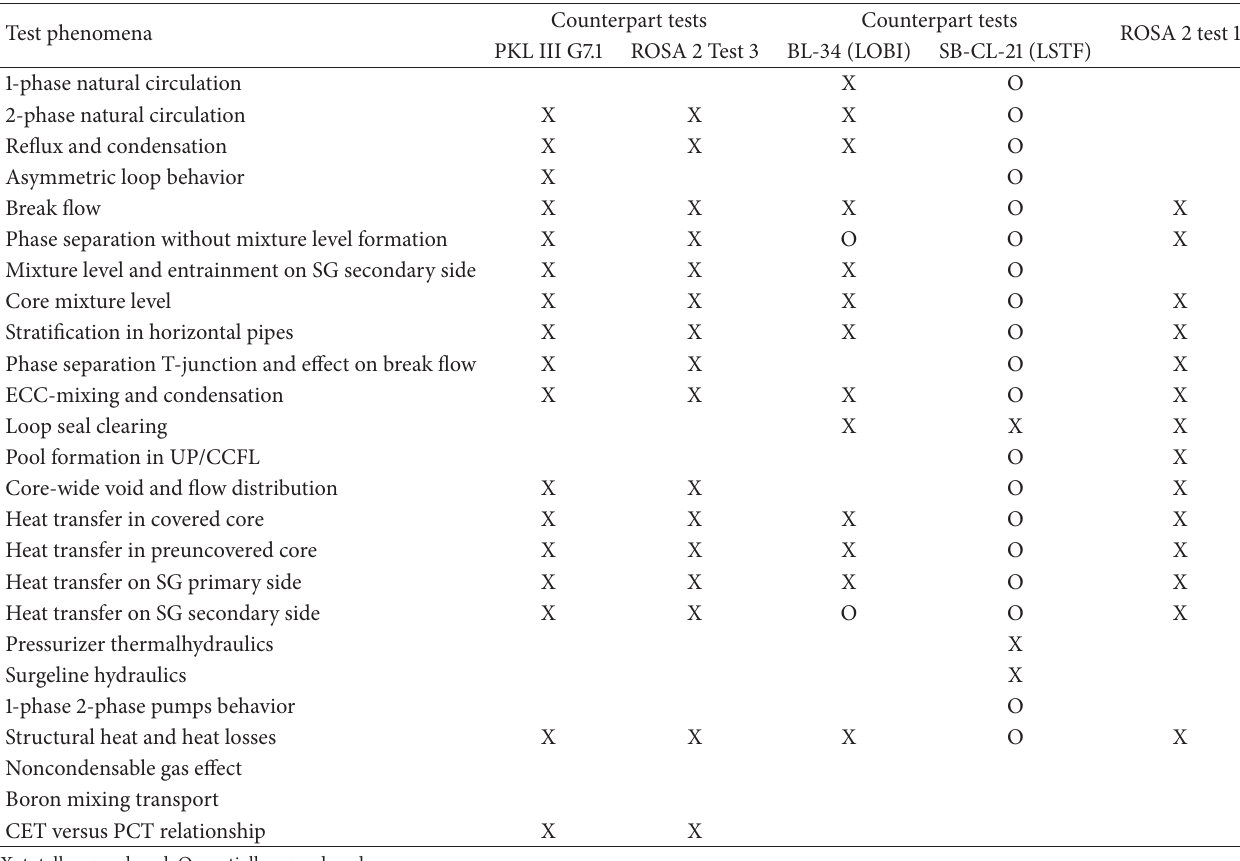
Table 1: NPP SBLOCA/IBLOCA validation